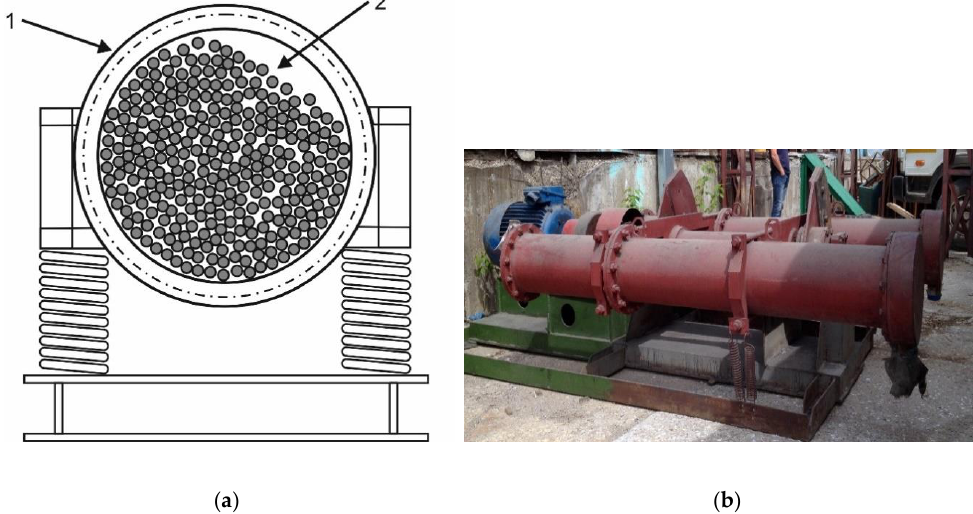
Figure 5. A vibration mill: ( a ) flow diagram; ( b ) photograph of the real-world K-50 equipment manufactured by NPO Novic Ltd. [60] (1—mechanochemical reactor; 2—the milling bodies); the photo was taken by Skripkina T.S, 2019.